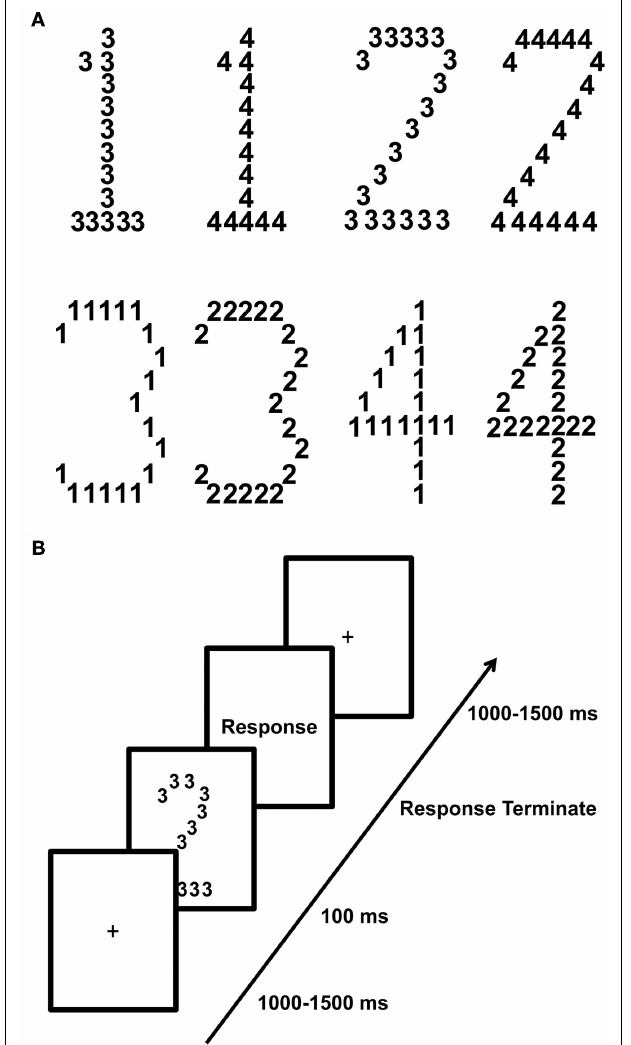
FIGURE 1 | Outline of the global-to-local paradigm and stimuli. A trial started with the presentation of a fixation cross lasting between 1 and 1.5s followed by the presentation of one of eight possible stimuli displayed in (A) . Subjects had to detect the target numbers 1 and 2 which appeared either at the global level or at the local level of the hierarchical stimulus and respond as quickly as possible via button press.They were instructed to press the “Z” key when the target 1 appeared and the “M” key when the target 2 appeared.The stimulus itself was presented for 100ms and replaced by a blank shown until the subject responded via a button press. (B) Outline of a single